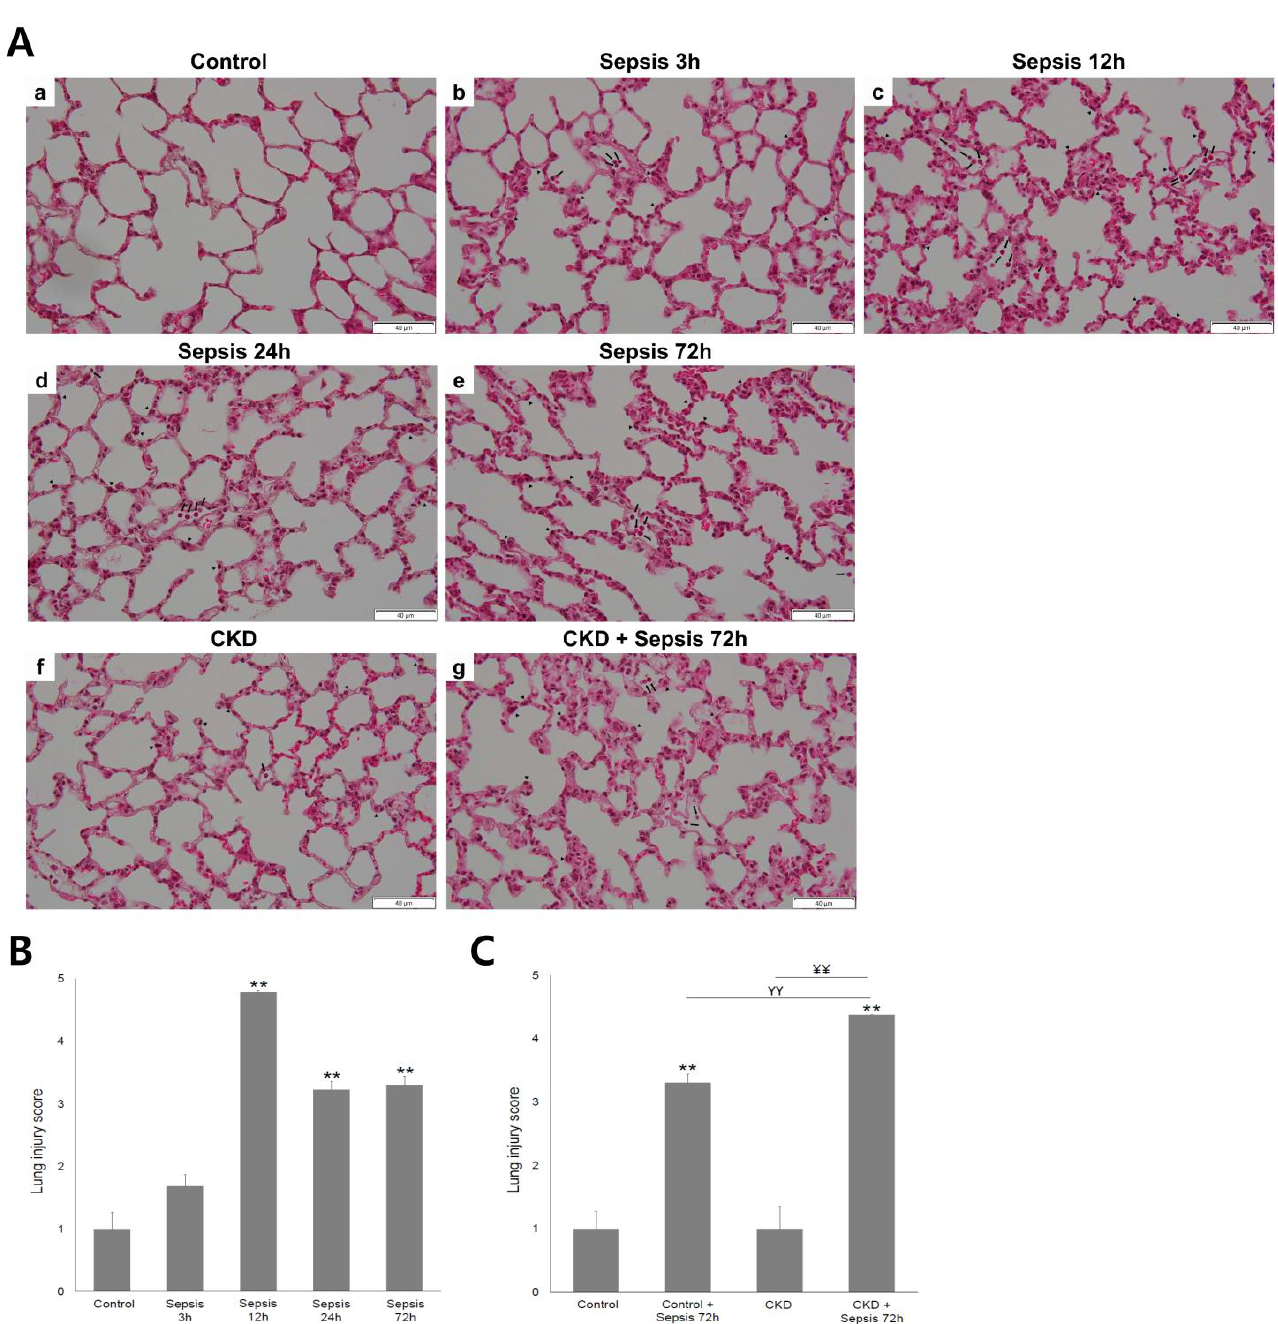
Figure 1. Photomicrographs of lung sections stained with hematoxylin–eosin and changes in lung injury scores according to the course of sepsis: ( A ) in the control group ( a – e ), acute lung injury (ALI) was most severe at 12 h of sepsis. Note that neutrophils were identified in the alveolar space (black arrow) and/or the interstitial space (arrowhead). In the chronic kidney disease (CKD) group ( f , g ), ALI was aggravated after 72 h of sepsis. Magnification, 400×; ( B ) the lung injury score was highest at 12 h of sepsis in the control group; ( C ) without sepsis, the lung injury score was similar between the control and CKD groups. After 72 h of sepsis, lung injury was significantly more severe in the CKD group than in the control group. Control, sham - operated model; sepsis model with 3, 12, 24, and 72 h after cecal ligation and puncture (CLP); CKD, chronic kidney disease (5/6 nephrectomized) model. ** p < 0.01 vs. control; ΥΥ p < 0.01 vs. sepsis 72 h; ¥¥ p < 0.01 vs. CKD. Error bars represent the standard error of the mean (SEM).